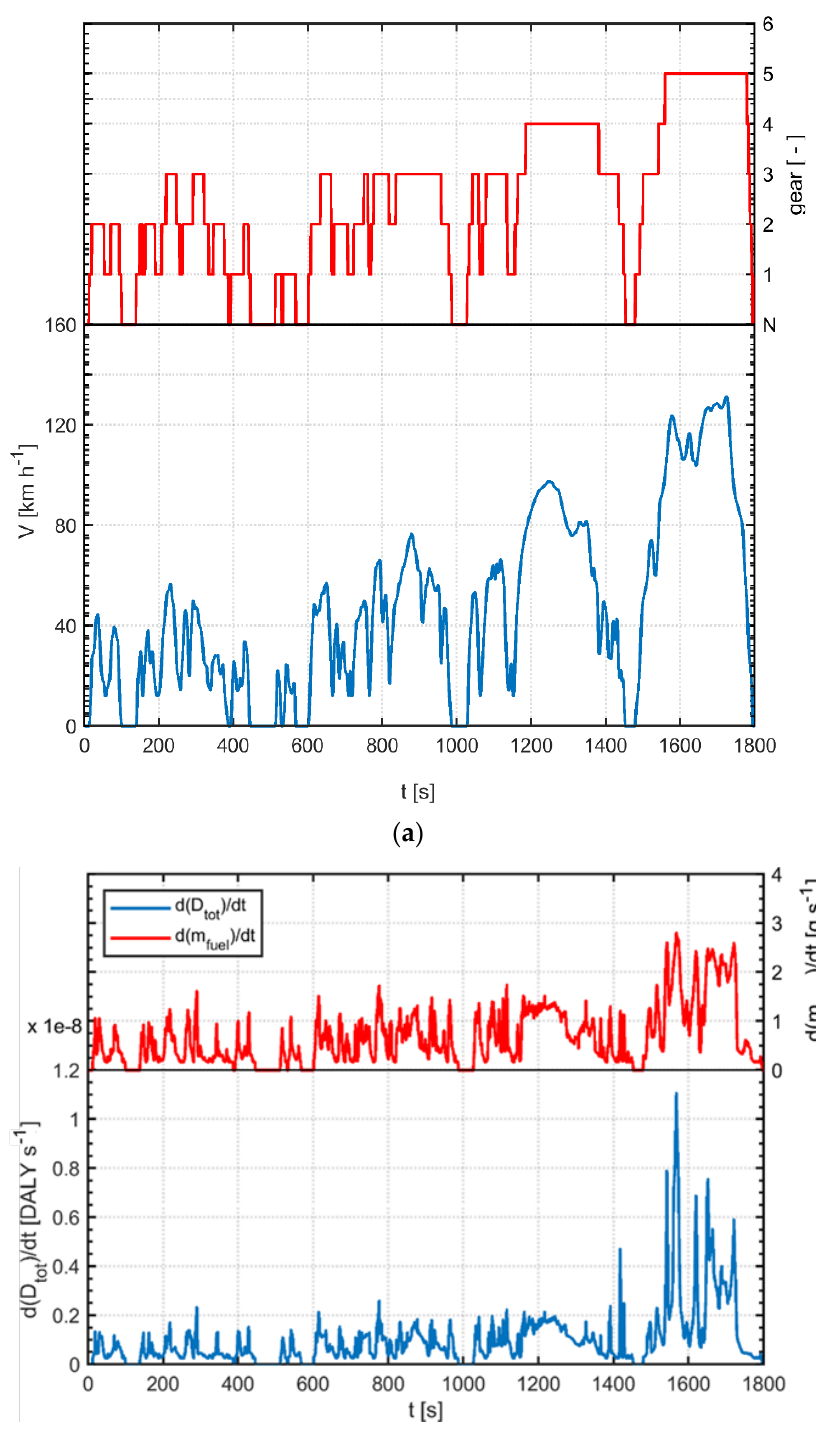
Figure 6. ( a ) WLTC cycle (blue line) and shifting points (red line) for the 6SG powertrain; ( b ) instantaneous fuel consumption (red line) and damage (blue line) for the 6SG powertrain.